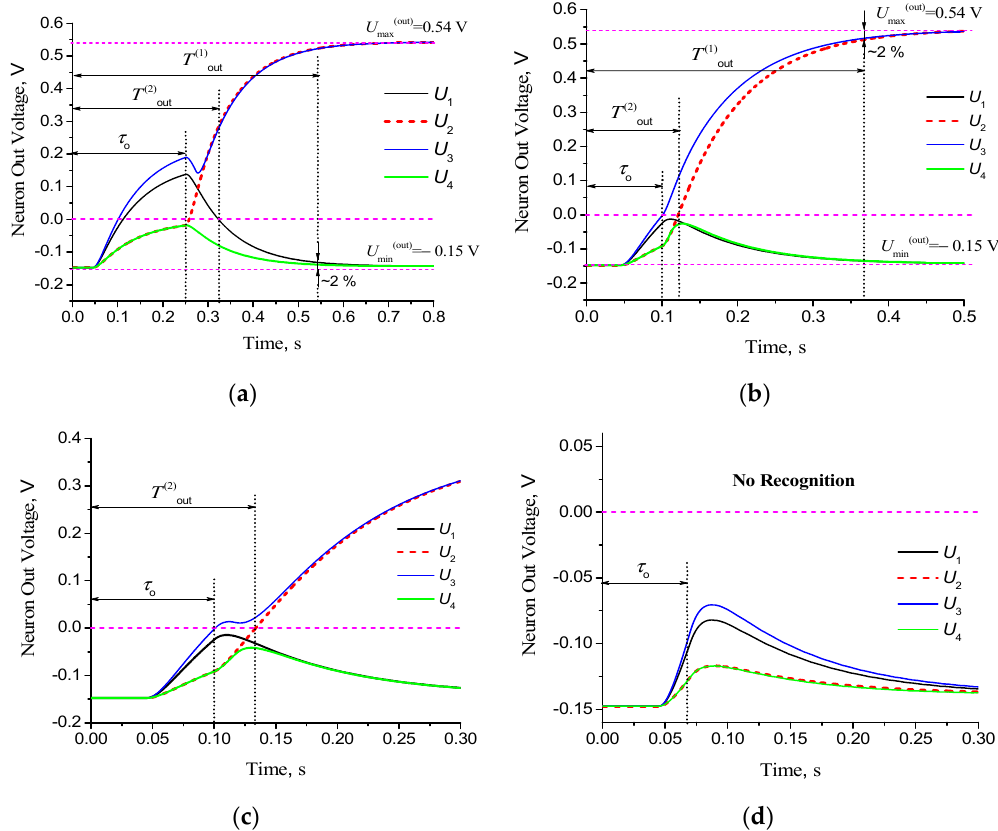
Figure 9. Diagrams of the output voltages of IHN2 neurons for the input template A (Figure 8). Calculation parameters of subfigures ( a – d ) are in Table 3.